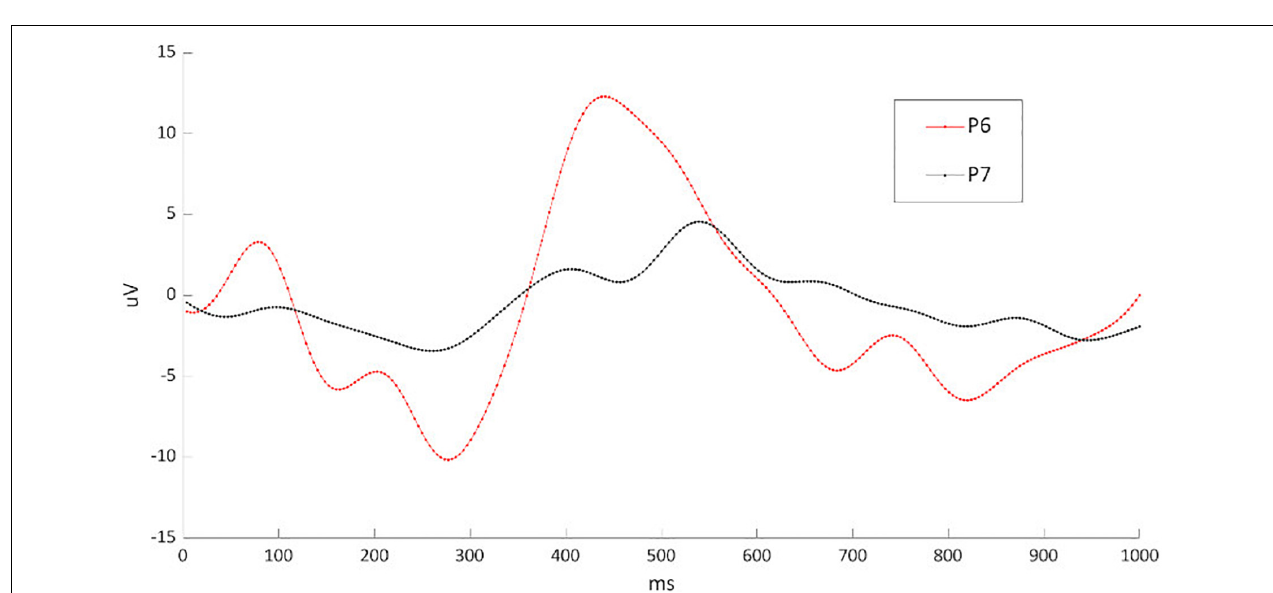
FIGURE 3 | Box plots compare the results for the two control mode conditions: Grid 3 Access via BCI control (left) and Grid 3 access via AT input (right). Online accuracy : the ratio between correct selections and selections needed to complete the task; time for correct selection : the ratio between the total time to complete the tasks and the number of correct selections; NASA-tlx: the overall workload scores in the NASA-tlx questionnaire ; System Usability Scale: level of satisfaction evaluated with the SUS. Box plots represent the distribution of the measurements, whiskers reach from minimum to maximum, the lines depict the medians, the “x” depicts the mean level, and the boxes cover the values between the first and third quartile. * indicates a significant difference ( p < 0.05).